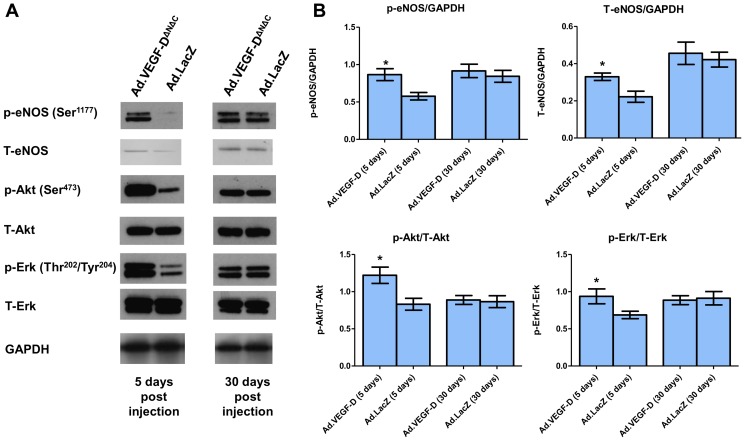
Effects of Ad.VEGF-DΔNΔC uterine artery transduction on phosphorylated (p) and Total (T) eNOS, Akt and Erk expression.(A) A representative blot shows upregulation of p-eNOS (Ser1177), T-eNOS, p-Akt and p-Erk in Ad.VEGF-DΔNΔC transduced UtAs compared to Ad.LacZ transduced UtAs 5 days after vector administration, but not 30 days after vector administration. Results are representative of n = 3 independent experiments each for the short-term and long-term time points. GAPDH was used as a loading control. (B) Densitometric analysis was performed on the western blots using Image J software, after normalizing against the density of GAPDH, T-Akt or T-Erk, as appropriate. Results are representative of n = 3 independent experiments. * indicates p<0.05 (t-test).